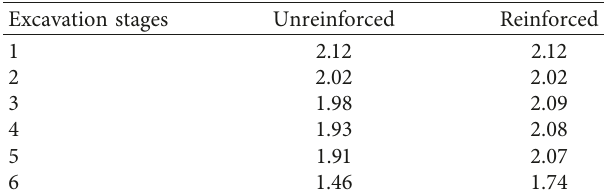
Figure 7: Numerical calculated and field monitored downward displacement data of the monitoring Point Y9 before and after the Table 6: Calculated FOS values of the rock slope with and without the reinforcement.